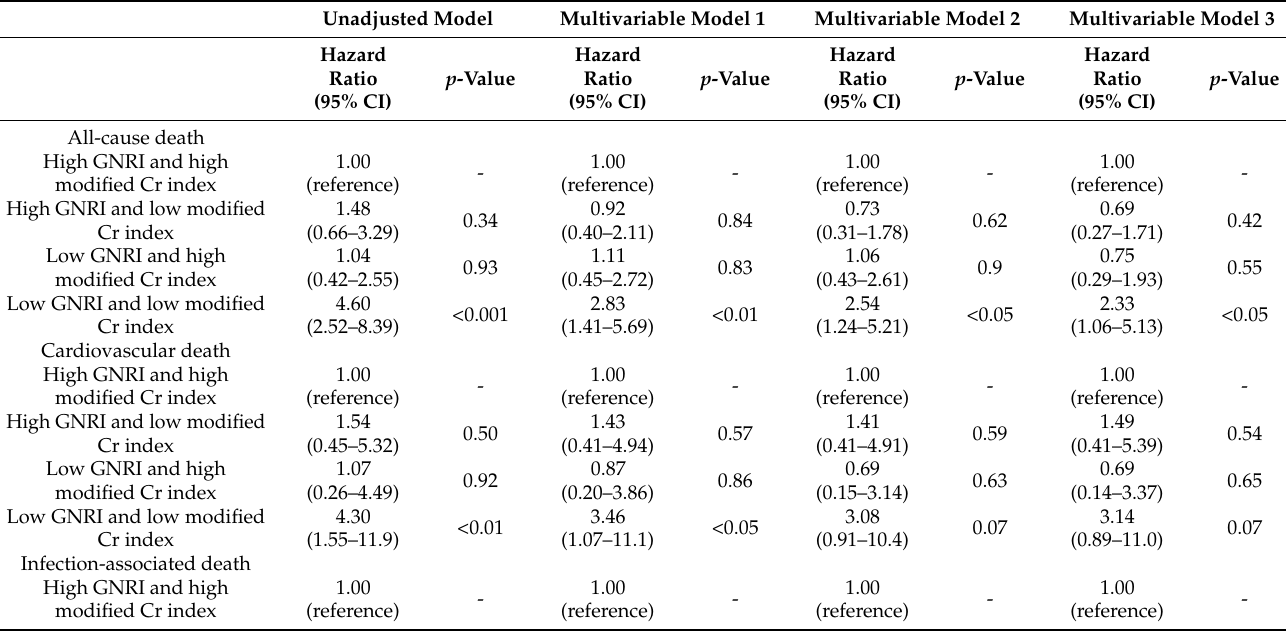
Table 4. Prognostic impacts of combination of both